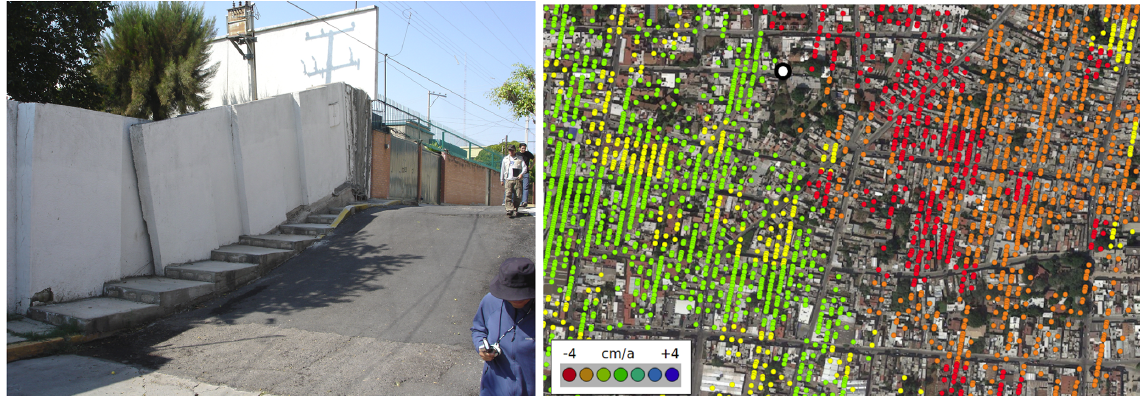
Figure 4. Celaya City (Guanajuato State): photograph of a road crossed by a geological fault (Sonora 206, Col. Centro, 38000 Celaya, Gto., Mexico) and extract of the subsidence map from ALOS-2 PALSAR-2 ScanSAR interferometry between 20 February 2015 and 16 Febru- ary 2018. The dot on the subsidence map indicates the location where the photograph was taken. Map data are from Bing Aerial (© Mi-